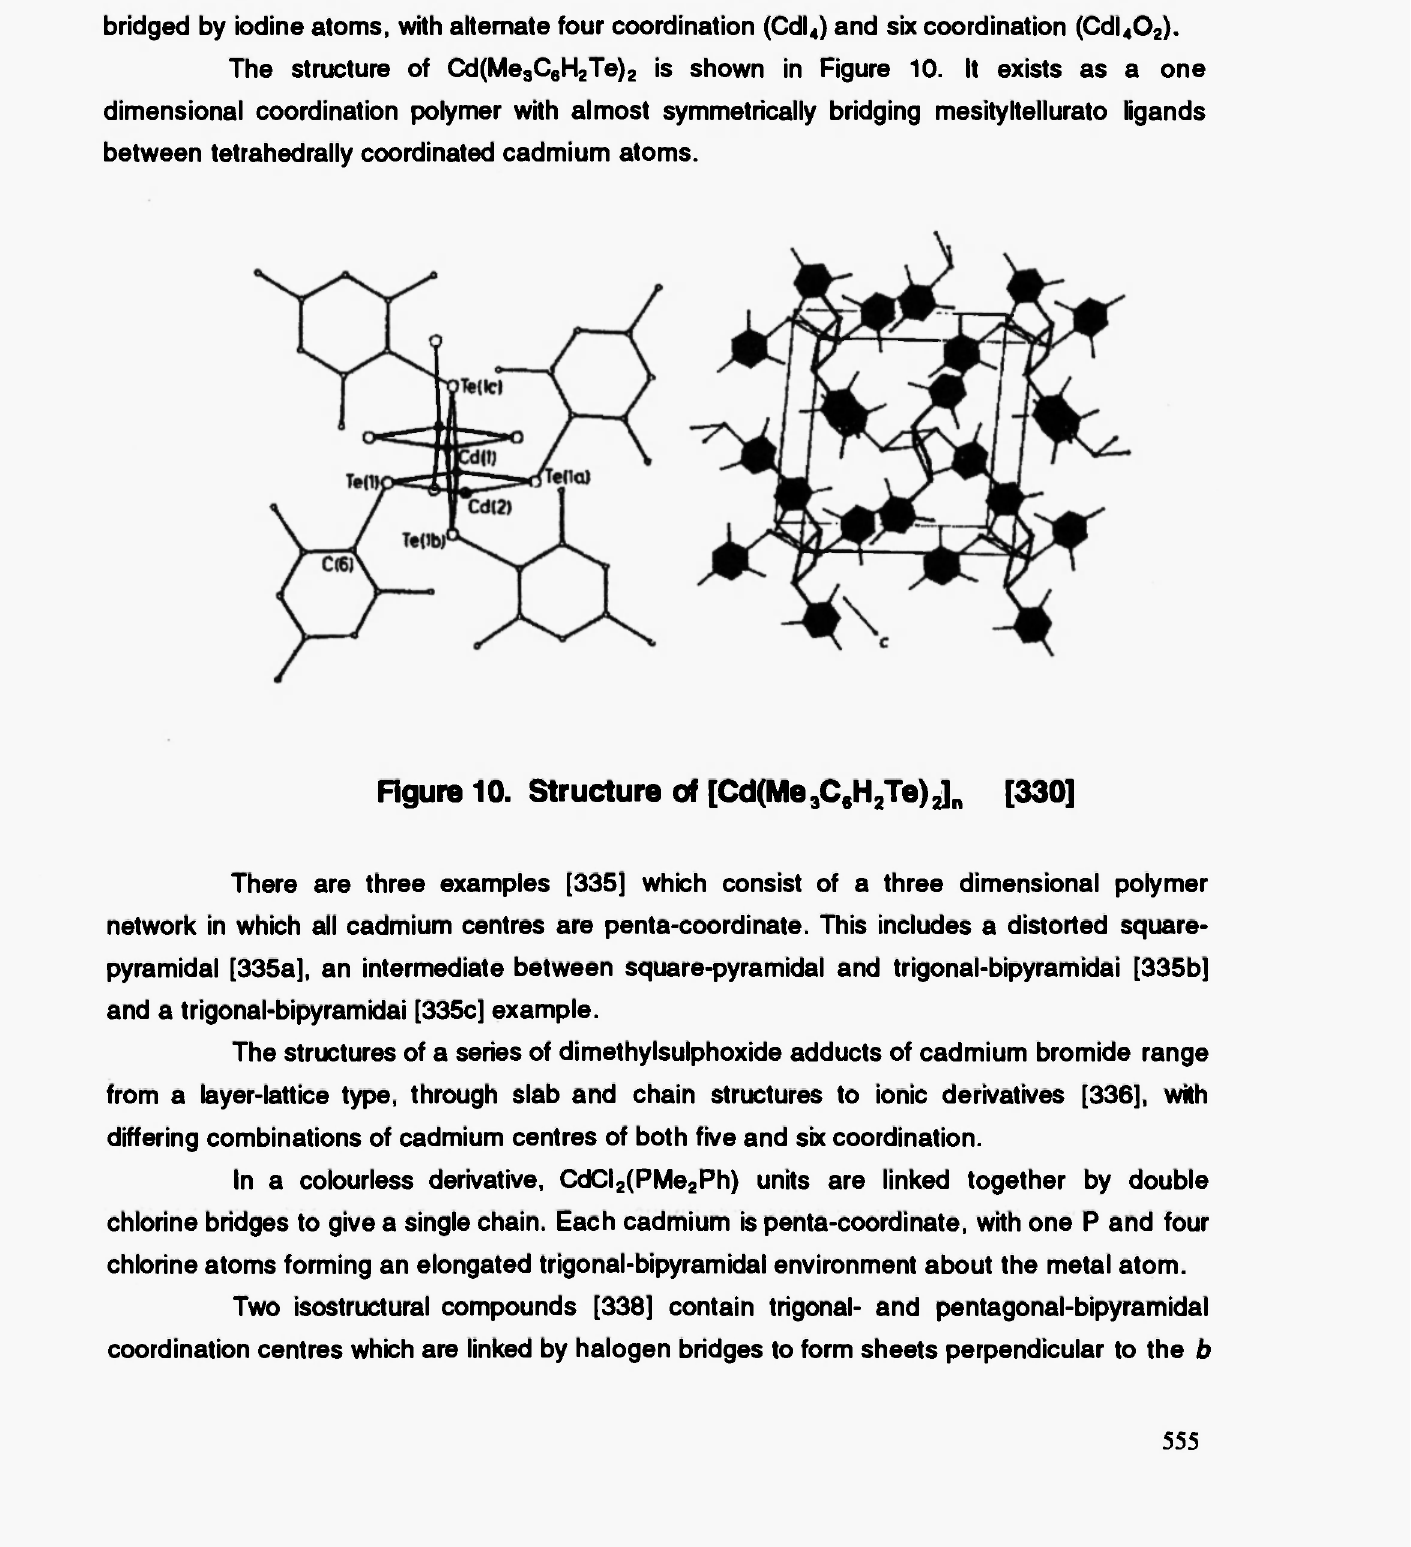
C H Te) ] 3 e 2 2 n